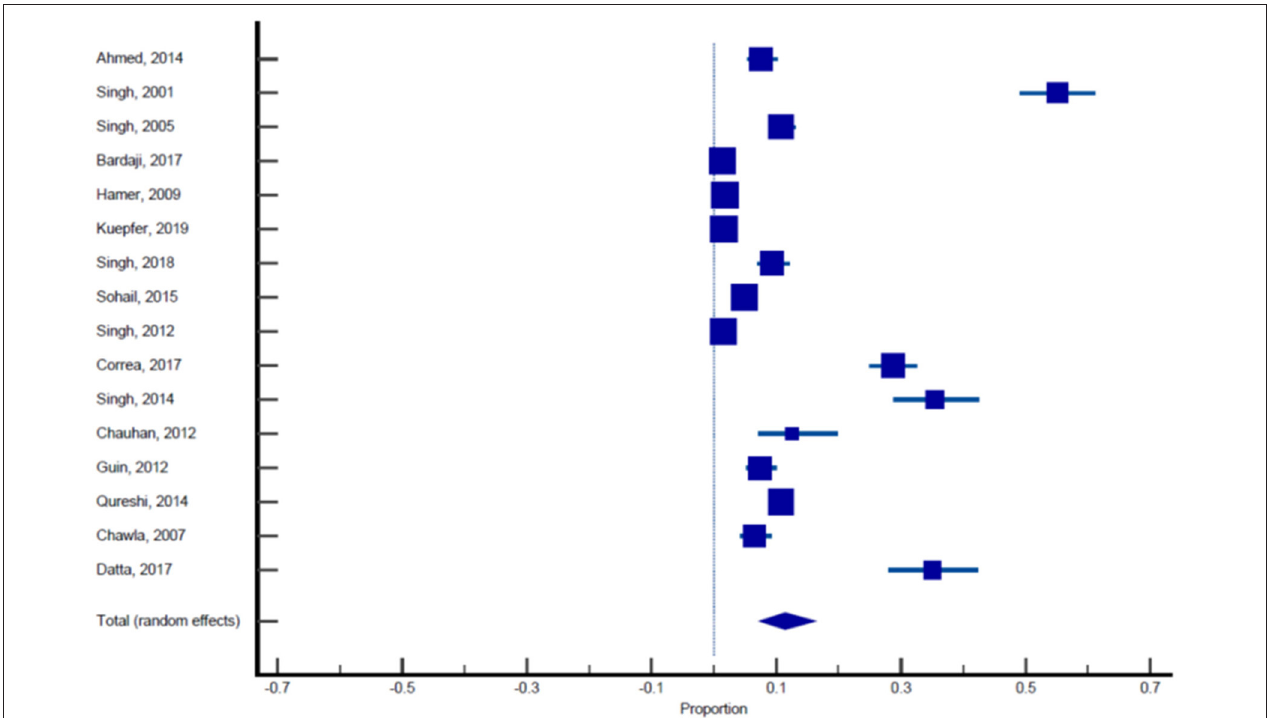
FIGURE 3 | Forest plot showing prevalence of malaria in pregnant females, the blue diamond indicates the pooled prevalence and the horizontal line shows the 95% confidence interval.